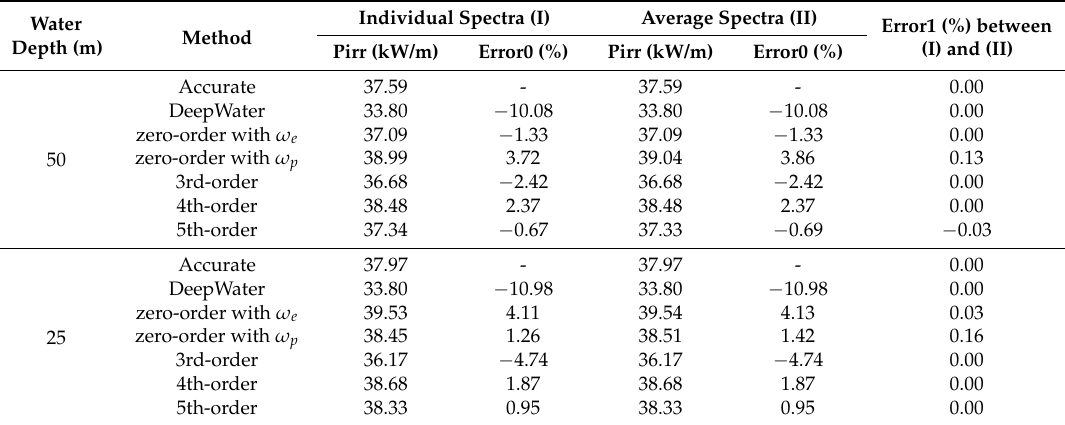
Table 1. Wave power assessment for AMETS (bin size: 0.5 m & 0.5